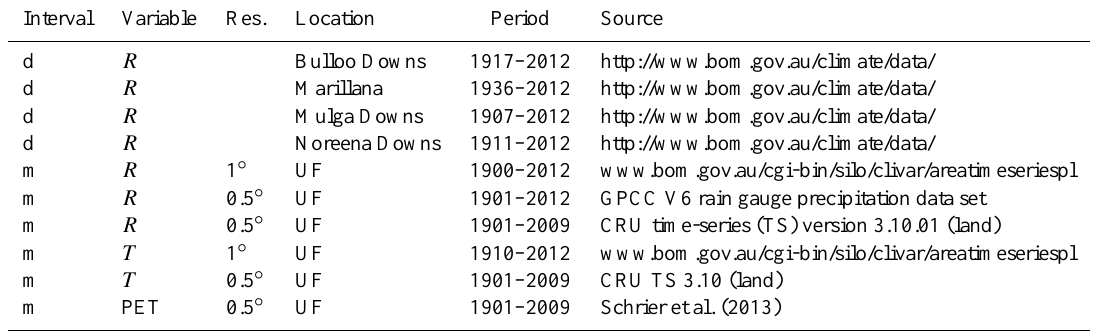
Table A3. Climate variables used in the development of a linear model to reconstruct historical flood area on the Fortescue Marsh, NW Aus- tralia.